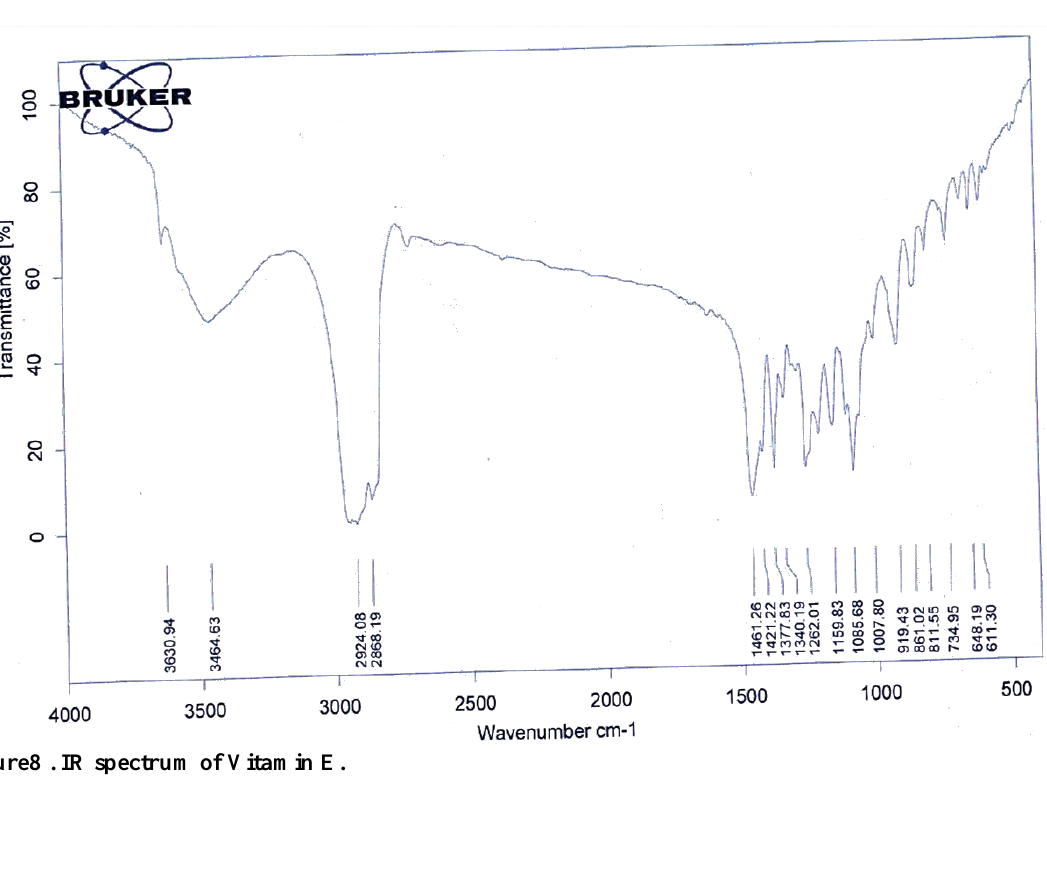
Figure 7. IR spectrum of tween 80 .